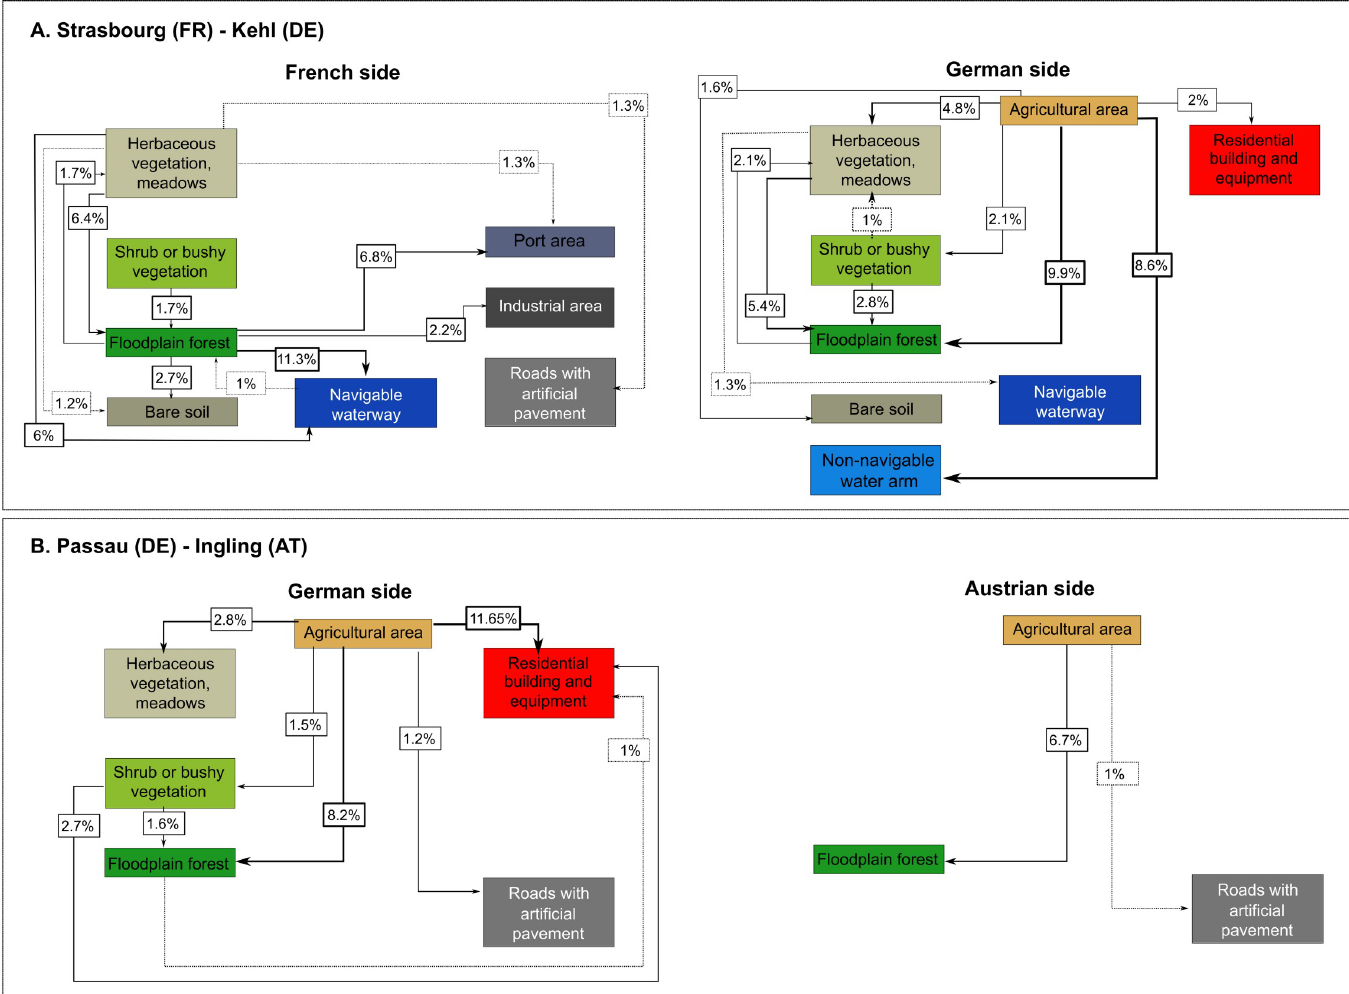
Fig 5. Visualization of transition matrices for the 1950s and 2010s for each country on opposite banks of the river. A. the Strasbourg-Kehl site (Upper Rhine region), and B. the Passau-Ingling site (Inn-Danube region).